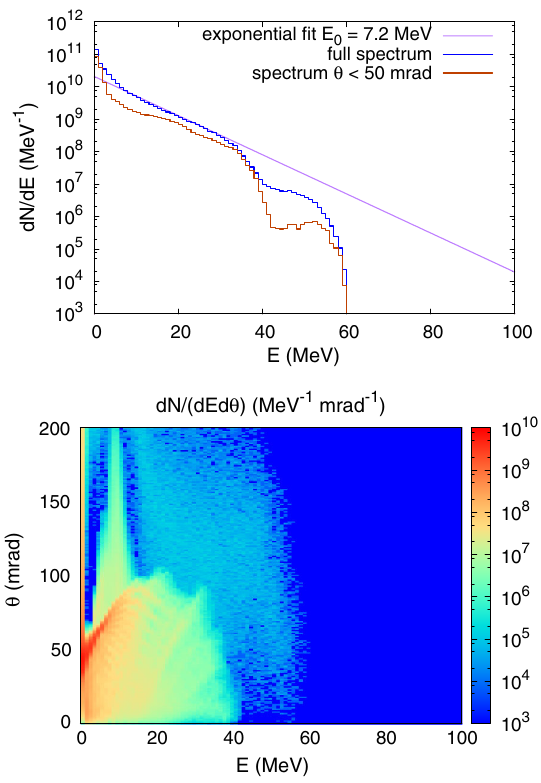
FIG. 2. Upper frame: Plot in a logarithmic scale of the proton initial energy spectrum (blue line) and after an angular selection (cid:7) < 50 mrad (light brown line) for the composite foam þ foil target (TNSA) with a ¼ 30 . Lower frame: Initial energy-angle distribution of the bunch in a logarithmic color